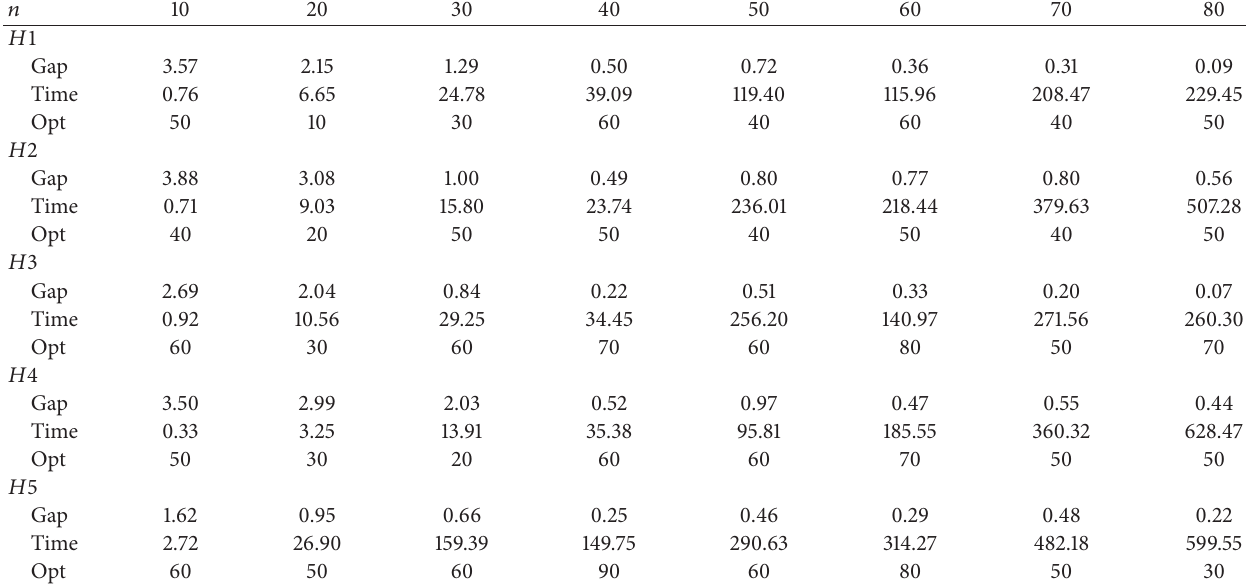
Table 13: Performance of the heuristics for 𝑚 = 4.